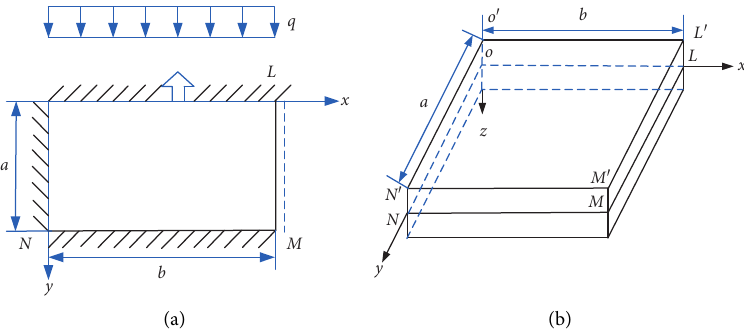
Figure 5: Mechanical model with fixed support on three sides and simple support on one side.